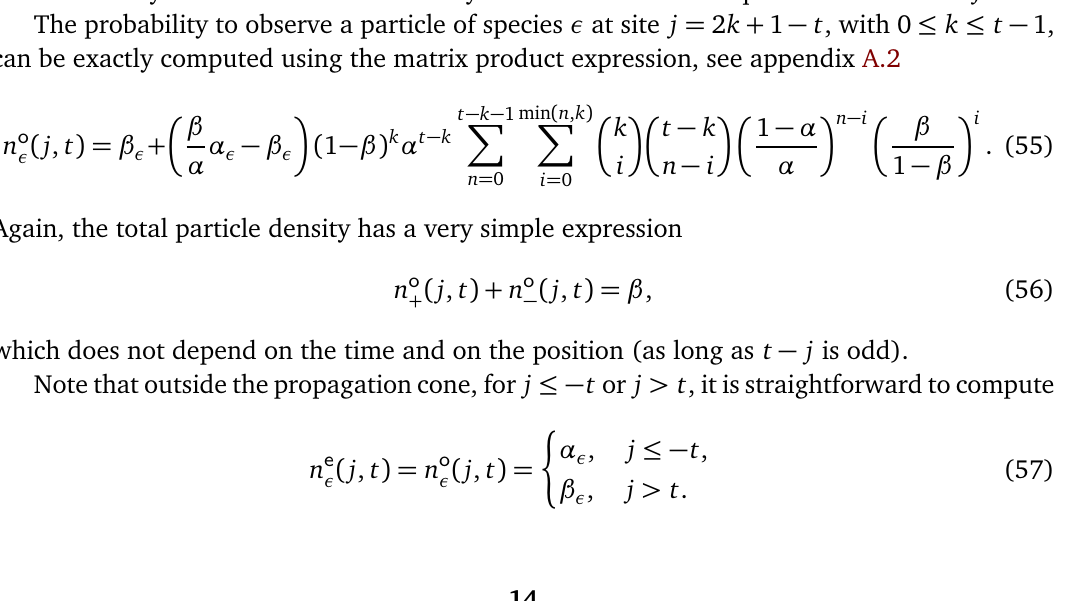
α − β t inside the propagation α + β